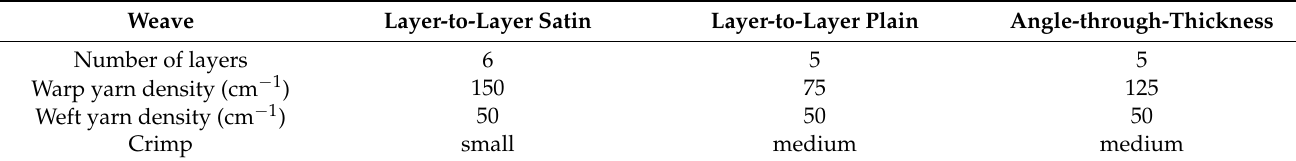
Table 1. Data of multilayer